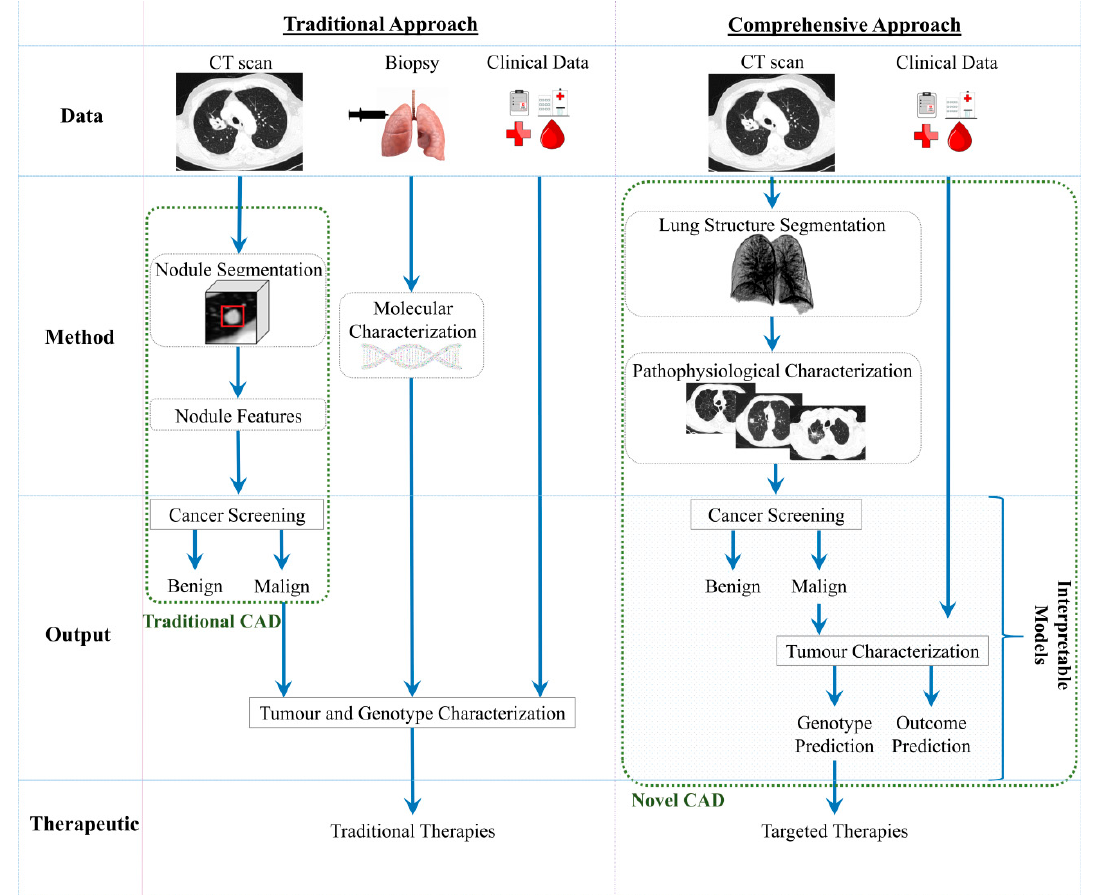
Figure 2. Conceptual diagram of the traditional and comprehensive approaches based on CADs. CT, computed tomography; CAD, computer-aided decision.